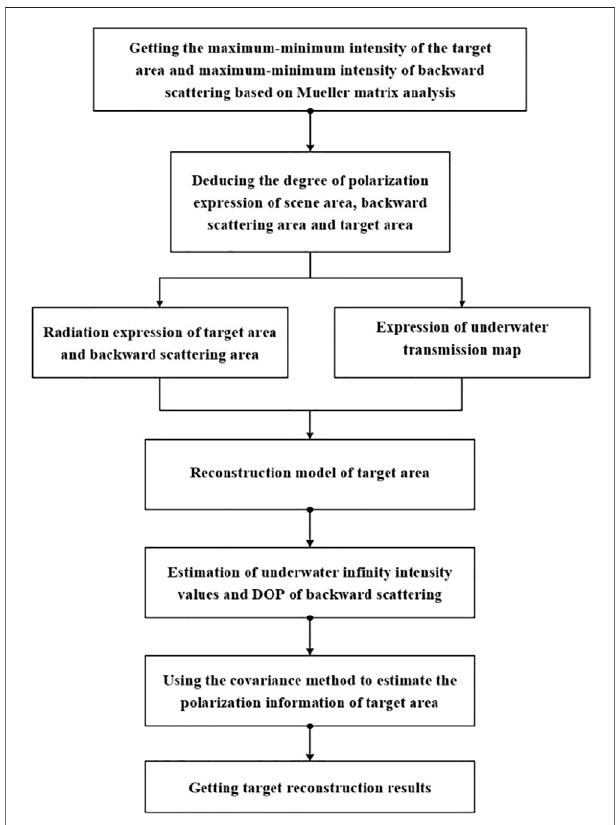
FIGURE 10 | The structure diagram of proposed